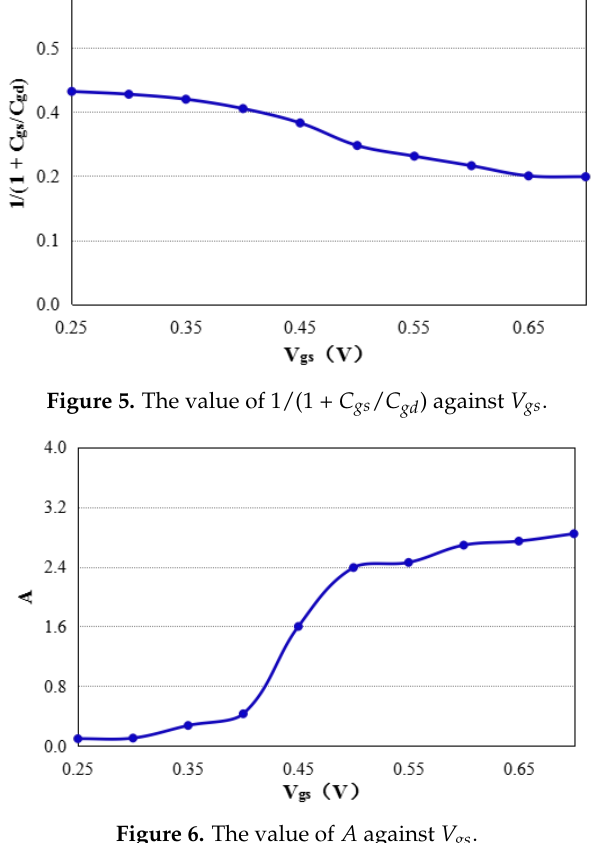
Figure 6. The value of A against V gs